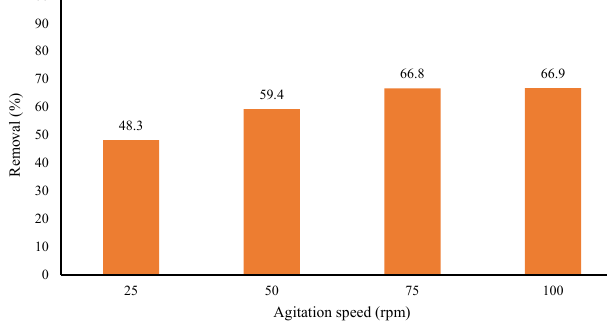
Fig. 4: Influence of bamboo activated carbon for removing nickel from electroplating industry wastewater against the agitation speed